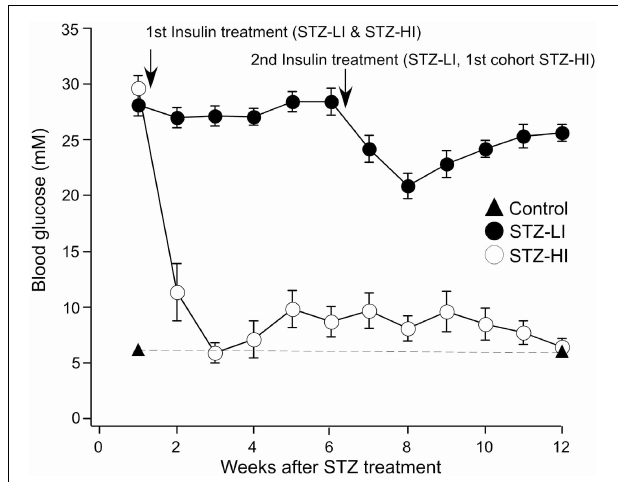
FIGURE 1 | Blood glucose levels (mM) measured at weekly intervals after i.p. injection of streptozotocin (STZ). Before the insertion of insulin pellets (at 1 week) all STZ-treated rats had elevated blood glucose levels. Throughout the 12-week period, STZ-treated rats given a low dose of insulin (STZ-LI, n = 22) maintained blood glucose levels > 15mM (i.e., hyperglycemic). Those given a high dose of insulin (STZ-HI, n = 19), at 3 weeks and thereafter had blood glucose measurements < 15mM. The graph also shows blood glucose measurements at 1 week and at 12 weeks in citrate buffer-treated control rats ( n = 30) and these data points are joined by the dashed line. The first arrow indicates the time at which the STZ-LI and STZ-HI rats received their first insulin pellet(s). The second arrow indicates the time the STZ-LI rats and the first cohort of STZ-HI rats received their second insulin pellet(s). The other STZ-HI rats were given additional insulin pellets when their blood glucose increased to between 10 and